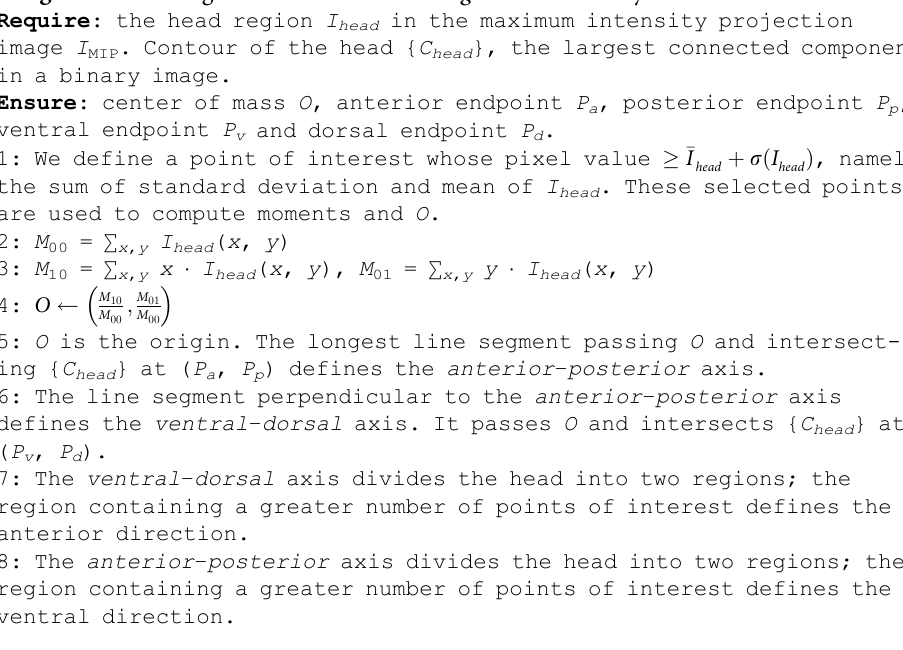
Algorithm 1 An algorithm to build the C. elegans coordinate